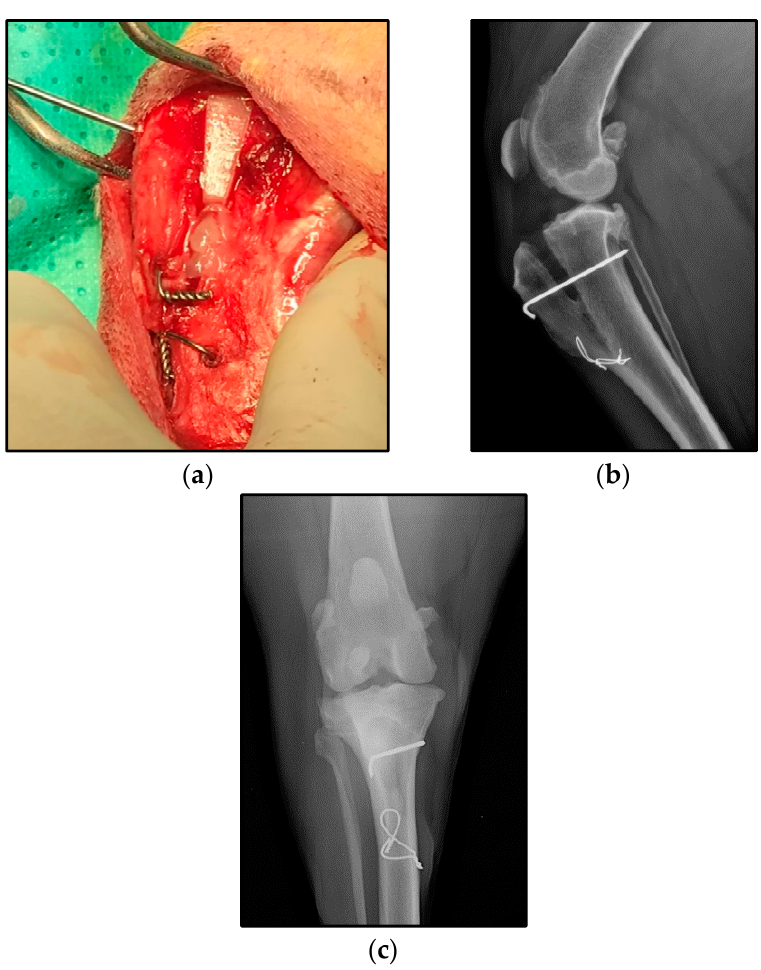
Figure 2. ( a ) PRGF clot placed. ( b , c ) Final result of the technique. The limb was evaluated in order to confirm the absence of positive cranial drawer motion and/or positive cranial tibial thrust and postsurgical radiographs were obtained to assess whether the implants were correctly placed. Finally, the closure of the surgical site was performed as described by Lafaver (2007) [3].